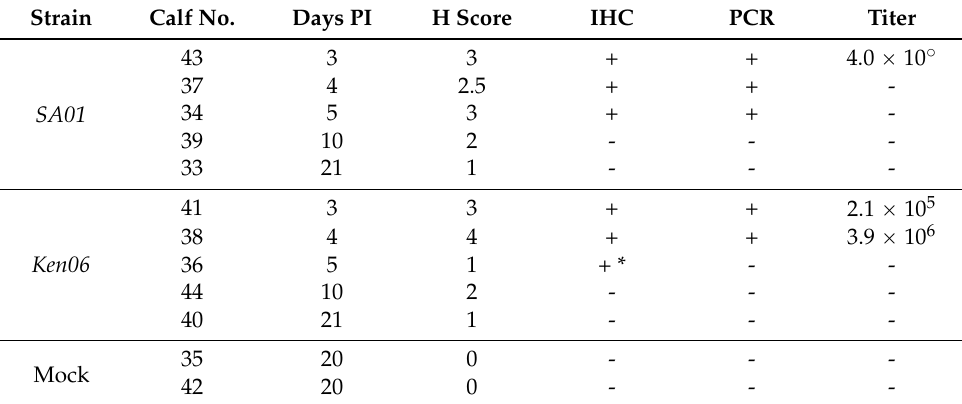
Table 5. Liver histopathology and immunohistochemistry for RVFV antigen. Strain